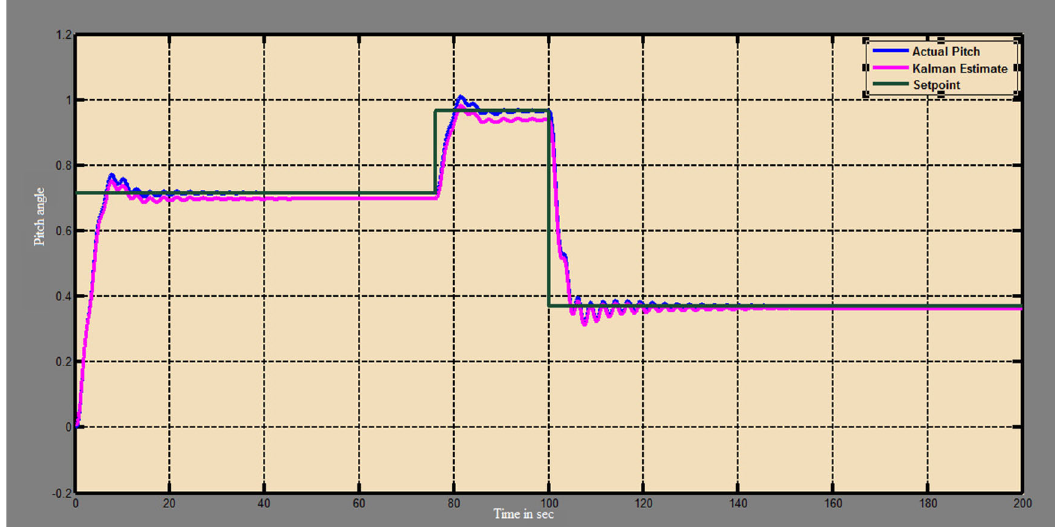
Figure 13. Estimation of the pitch with Kalman filter.